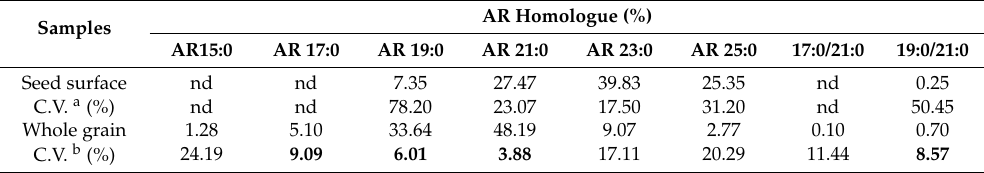
Table 1. Average relative proportions of AR homologue, 17:0/21:0 and 19:0/21:0 of 36 wheat samples cultivated in 2017 in